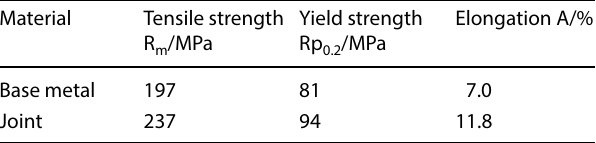
Table 4 Mechanical propeties of WE43 magnesium alloy EBW base metal and joint Material Tensile strength R m